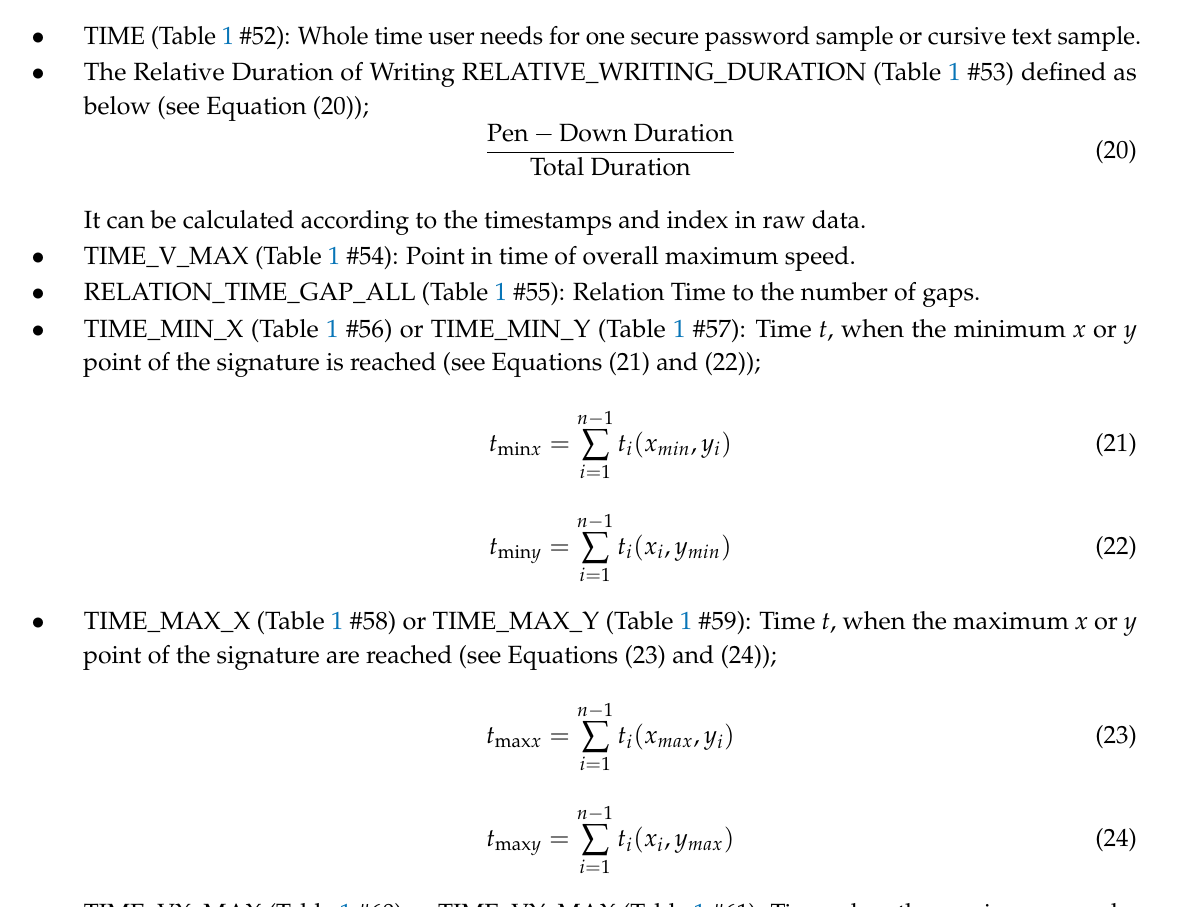
(Table 1 #51): Division number of points x or y/number of all